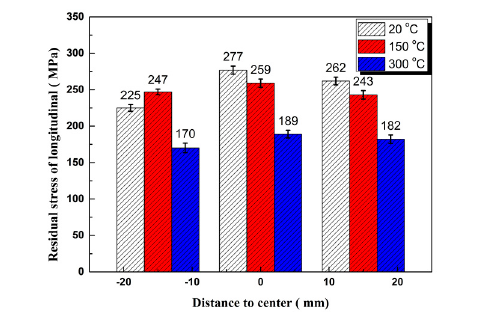
Figure 9. Diagram of residual stress test points.